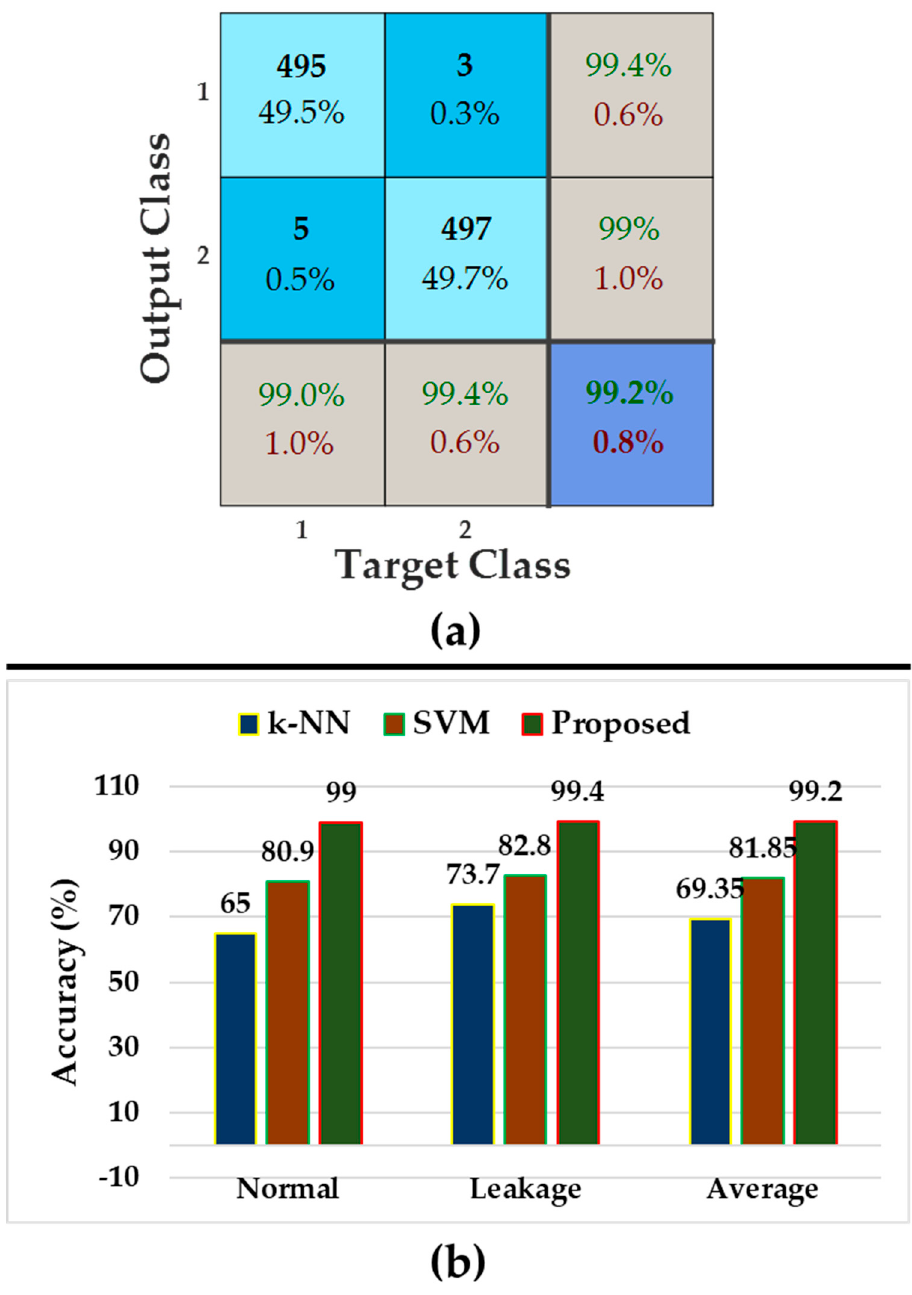
Figure 10. ( a ) Confusion Matrix of the proposed model; ( b ) Results (accuracy (%)) comparison of the proposed boiler tube leakage classification model with other state-of-the-art fault diagnosis models.